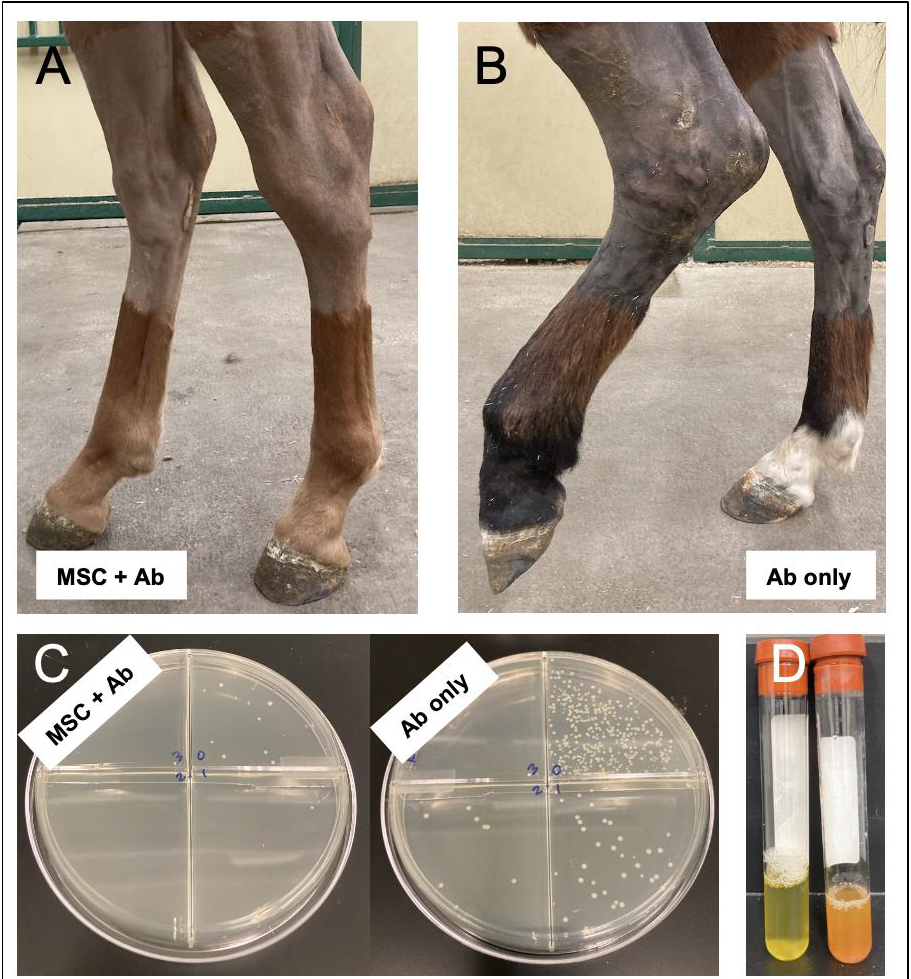
Figure 2. Evaluation of TLR poly I:C activated bone marrow derived MSC therapy in an equine model of multi-drug resistant USA300 methicillin resistant Staphylococcus aureus [25]; original unpublished images presented with permission from the authors]. Representative images of horses at day 7 following intra-articular inoculation of the left tarsocrural joint treated with three intra-articular injections of ( A ) MSC and antibiotics, or ( B ) antibiotics alone. Quantitative bacterial cultures were significantly reduced in horses treated with ( C ) MSC and antibiotics versus ( D ) antibiotics alone. Synovial fluid parameters serum amyloid A, lactate, and inflammatory biomarkers IL-6 and IL-18 were significantly improved in horses treated with MSC and antibiotics (left) versus antibiotics alone (right) ( D ).